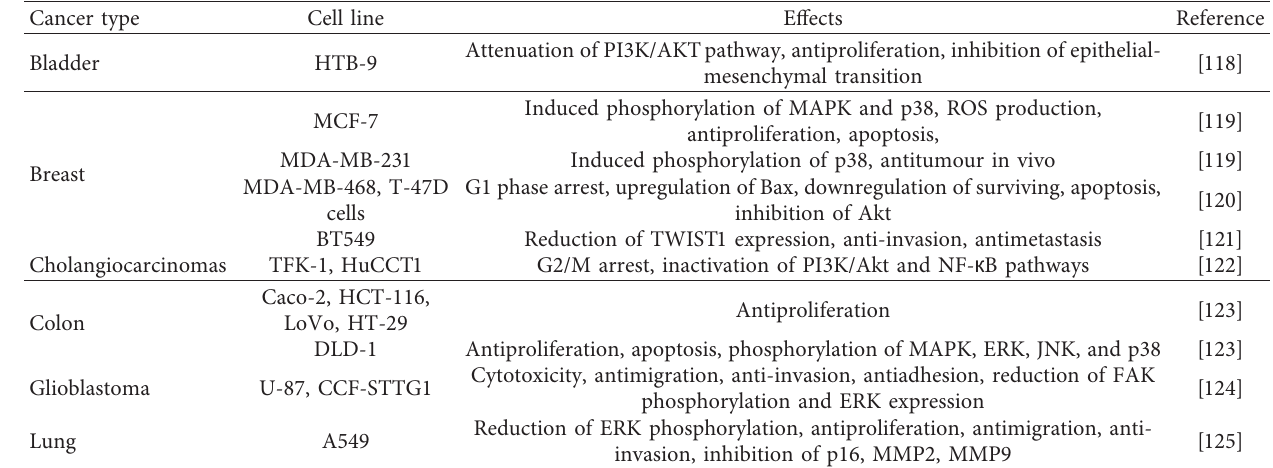
Table 5: The anticancer effects of thymoquinone on different cell